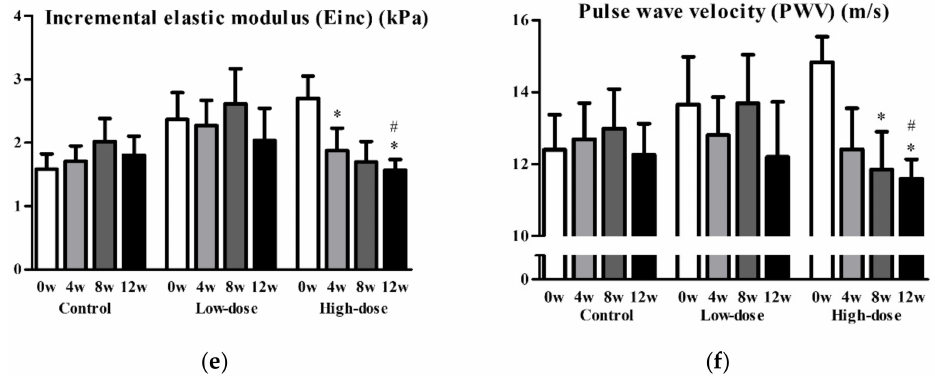
Figure 2. Diastolic blood pressure ( a ), systolic blood pressure ( b ), sti ff ness parameter β ( c ), distensibility ( d ), incremental elastic modules ( e ), and pulse wave velocity ( f ) before and after the intervention in non-smoking groups. Data are presented as mean and standard error. * P < 0.05 vs. baseline, paired t-test. # P < 0.05, change from baseline vs. placebo, unpaired